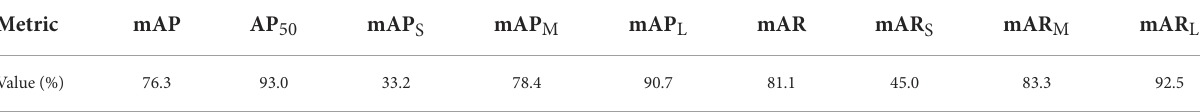
TABLE 3 Based on the optimized mask RCNN model, the average precision, and average recall of persimmon datasets at different thresholds, sizes, and quantities are analyzed.